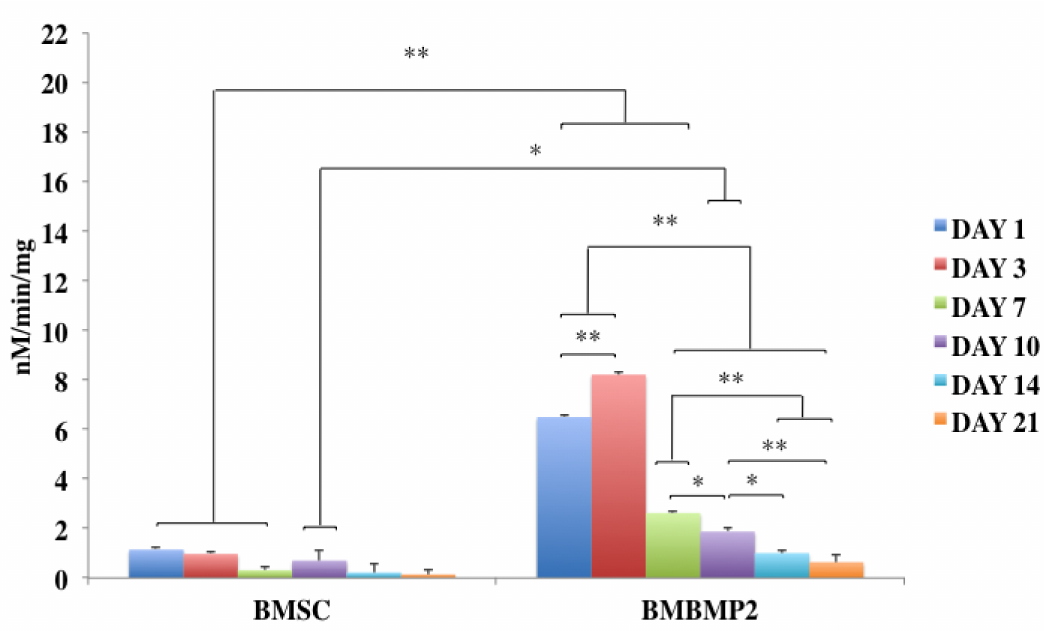
Figure 7. Shows ALP activity, bone mineralization marker, of immortalized mouse BMSCs photoencapsulated in visible light-cured thiol-acrylate hydrogels at days 1, 3, 7, 10, 14, and 21. Y -axis shows nano-molar/min/mg, X -axis shows control groups of photoencapsulated-BMSCs without BMP-2 (BMSCs) and experimental groups of photoencapsulated-BMSCs with